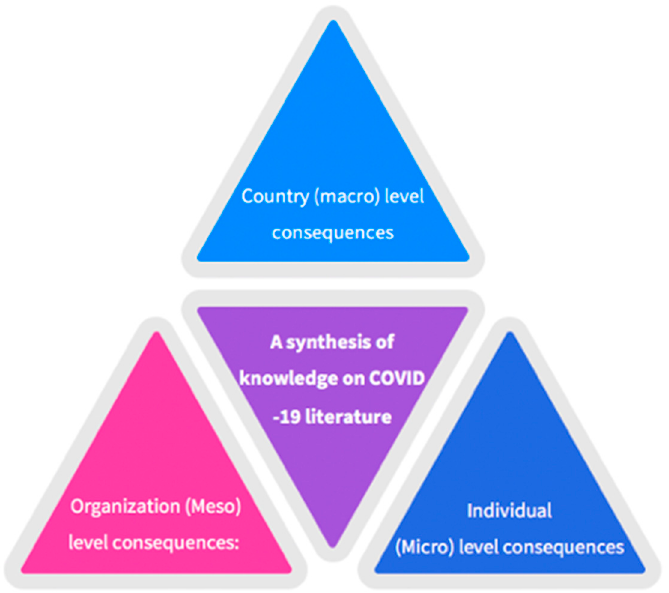
Figure 6. Macro (country level), meso (organization level), and micro (individual level).